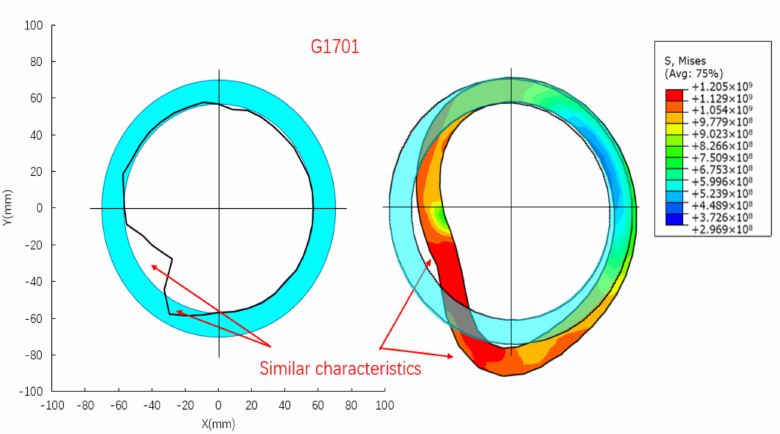
Figure 12. Concave deformation section of G1701 (black curve) and model 9030 (colored circle) against the initial casing section (blue